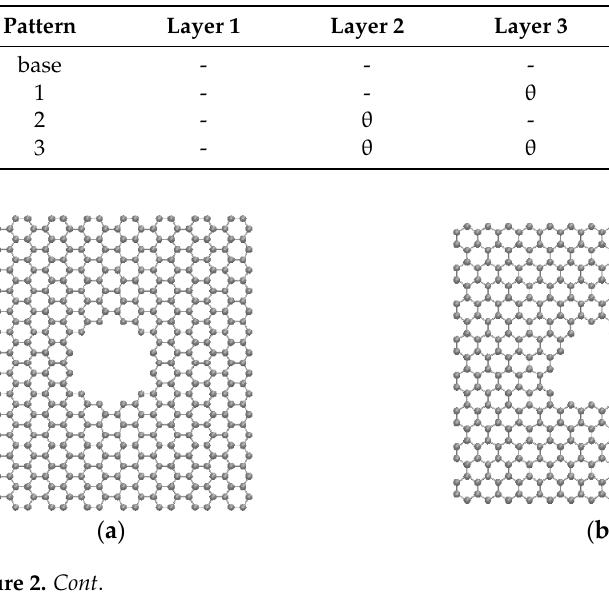
Figure 1. The computational domain.